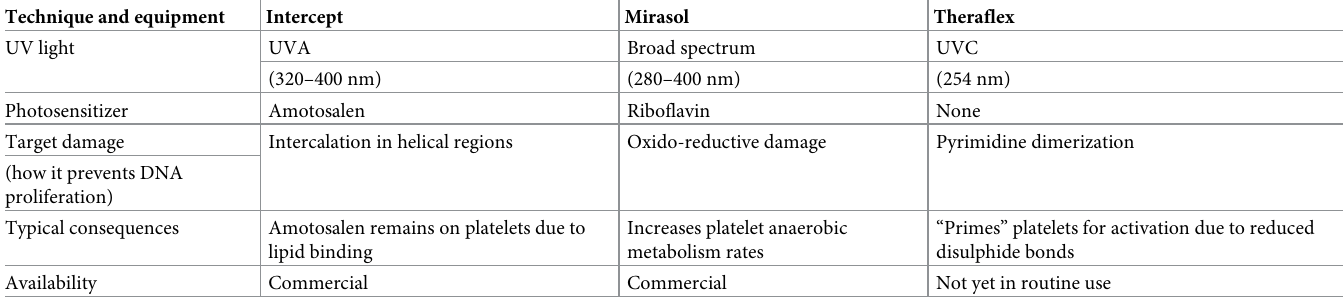
Table 1. Characteristics of pathogen inactivation systems [17, 20,